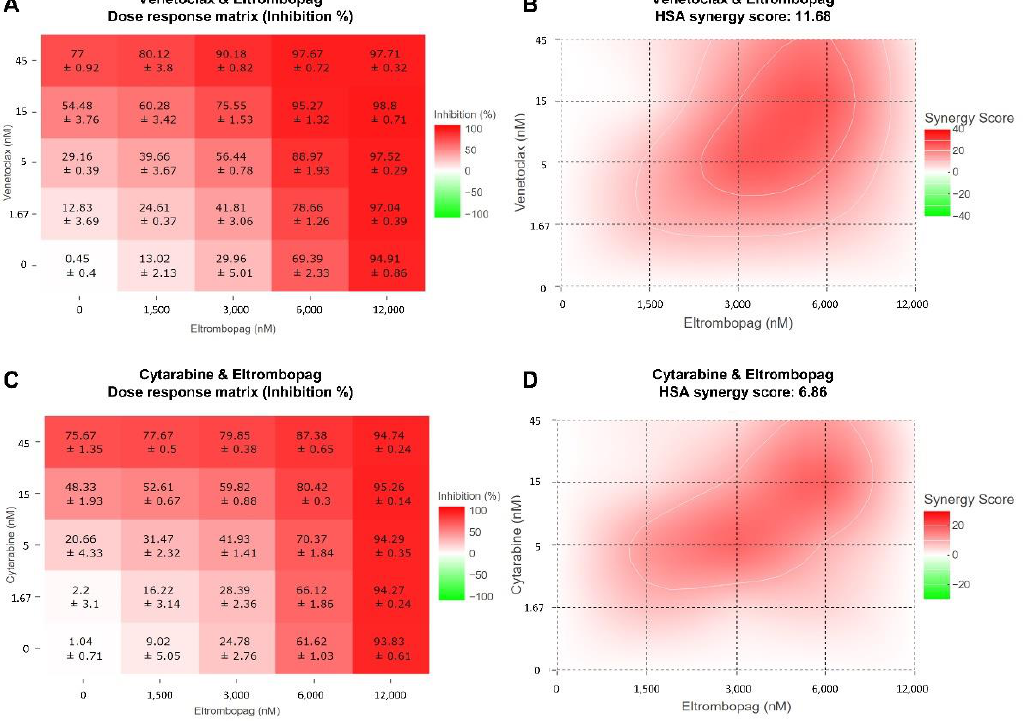
Figure 8. Synergistic effect of the combination treatment of eltrombopag and current AML drugs, venetoclax and cytarabine, on MOLM-13. ( A ) Dose-response matrix for the venetoclax/eltrombopag combination in MOLM-13 cell line. ( B ) 2D synergy maps and calculated HSA synergy scores for the venetoclax/eltrombopag combinations using Synergyfinder software. ( C ) Dose-response matrix for the cytarabine/eltrombopag combination in MOLM-13 cell line. ( D ) 2D synergy maps and calculated HSA synergy scores for the cytarabine/eltrombopag combinations using Synergyfinder software. Red and green areas represent synergy and antagonism, respectively. All experiments were repeated at least three times.